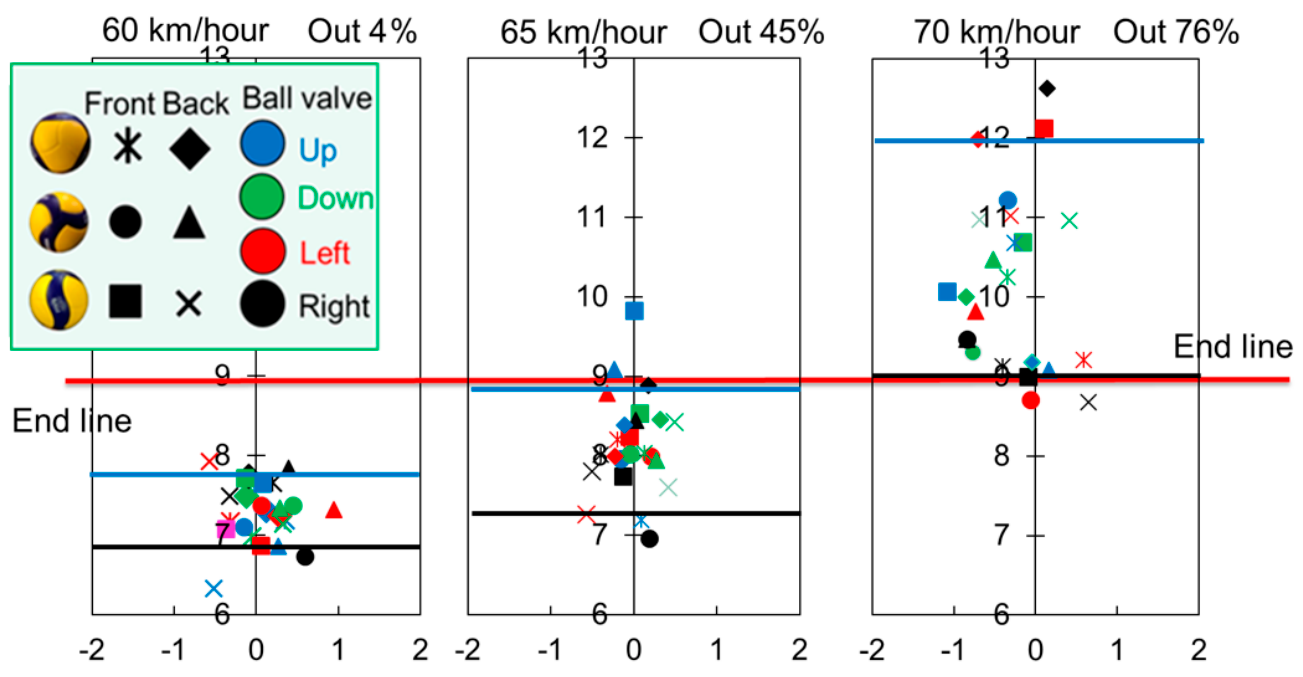
Figure 14. Average landing point for each panel in Figure 10.